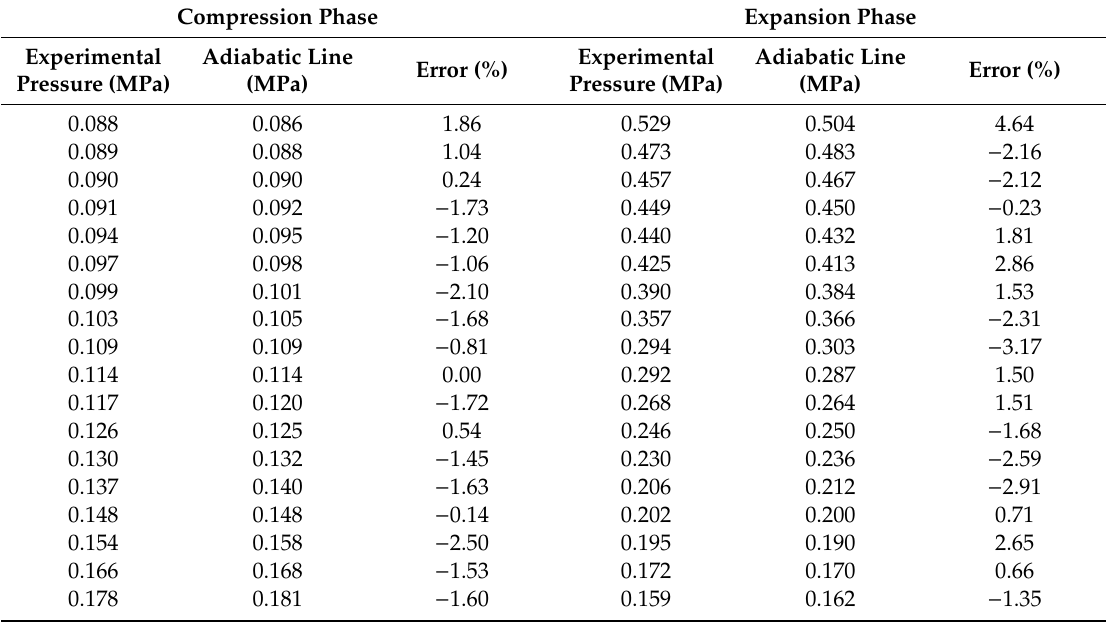
Figure 4. Comparison of theoretical adiabatic pressure variations and experimental data in a p–V diagram. Table 2. The error between theoretical adiabatic pressure variations and experimental data.